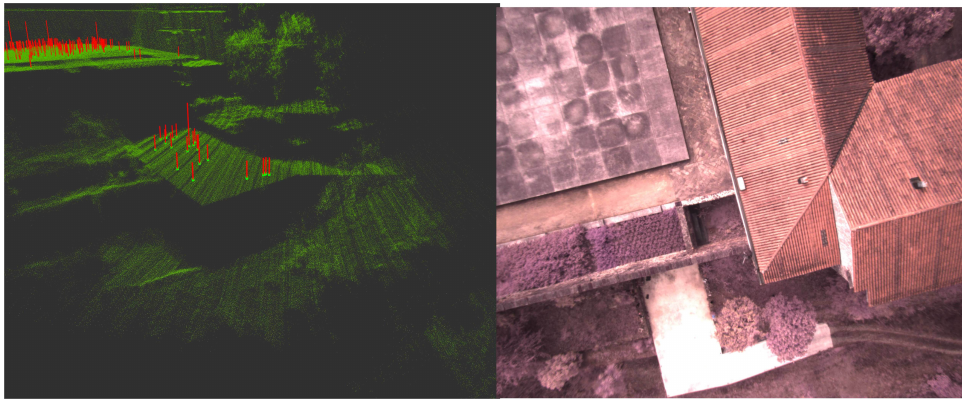
Figure 15. Point cloud, spots, and camera image near entrance.